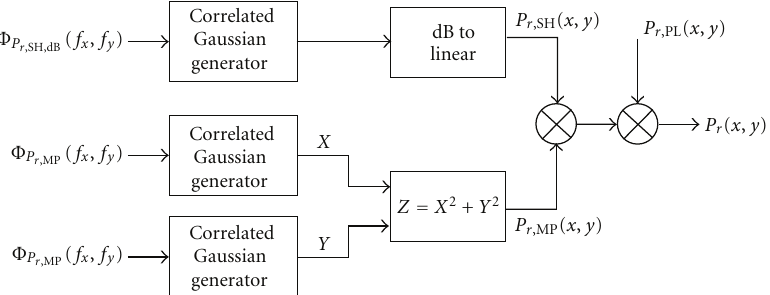
Figure 15: Block diagram of the two-dimensional probabilistic channel simulator for networked robotic